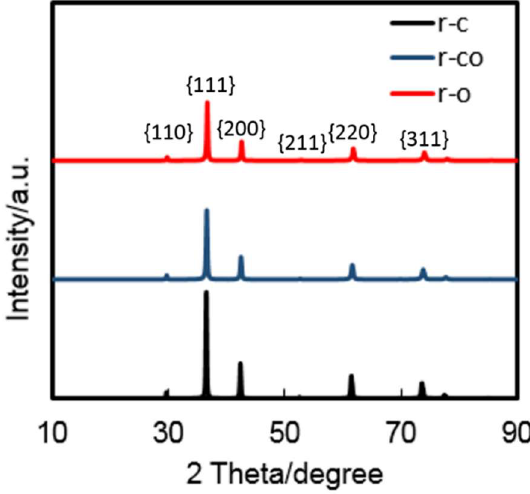
Figure 2. XRD patterns of faceted Cu 2 O particles (FCPs).